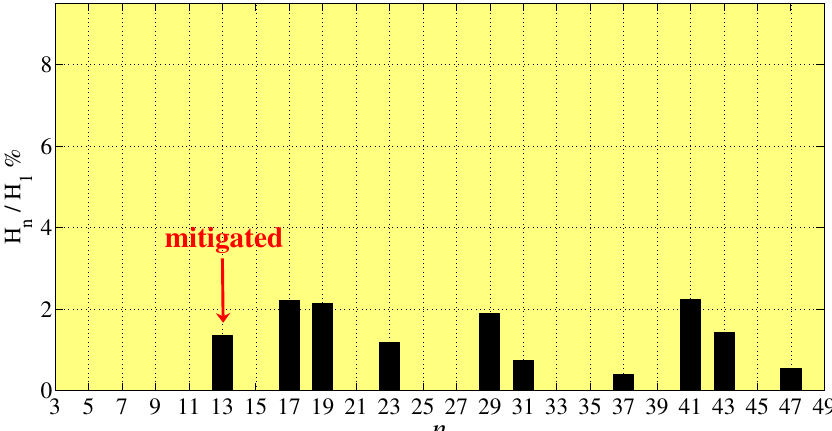
Figure 6. Percentage values of harmonics amplitudes H n with respect to the fundamental H 1 for three-phase 9-level